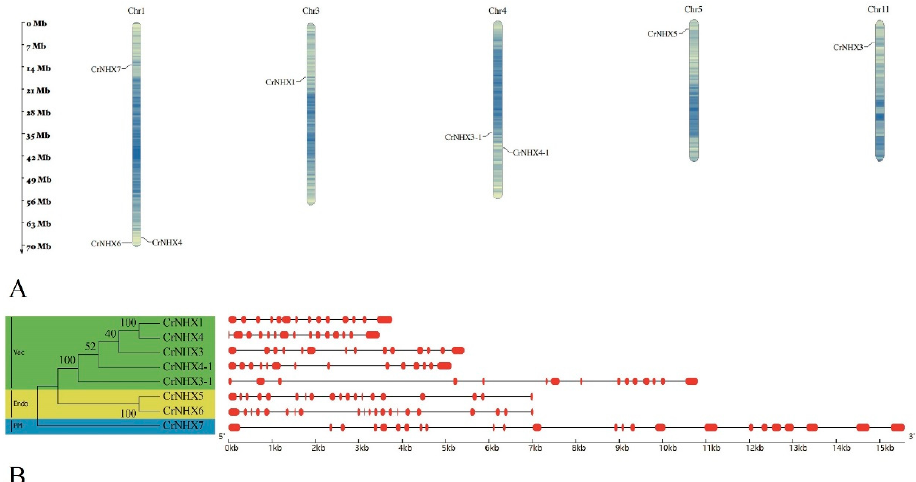
Figure 1. ( A ) Locations of the 8 CrNHX s on 11 chromosomes of C. rosea . ( B ) Subgroup classification of CrNHXs ( left ) and their gene exon–intron structures ( right ).